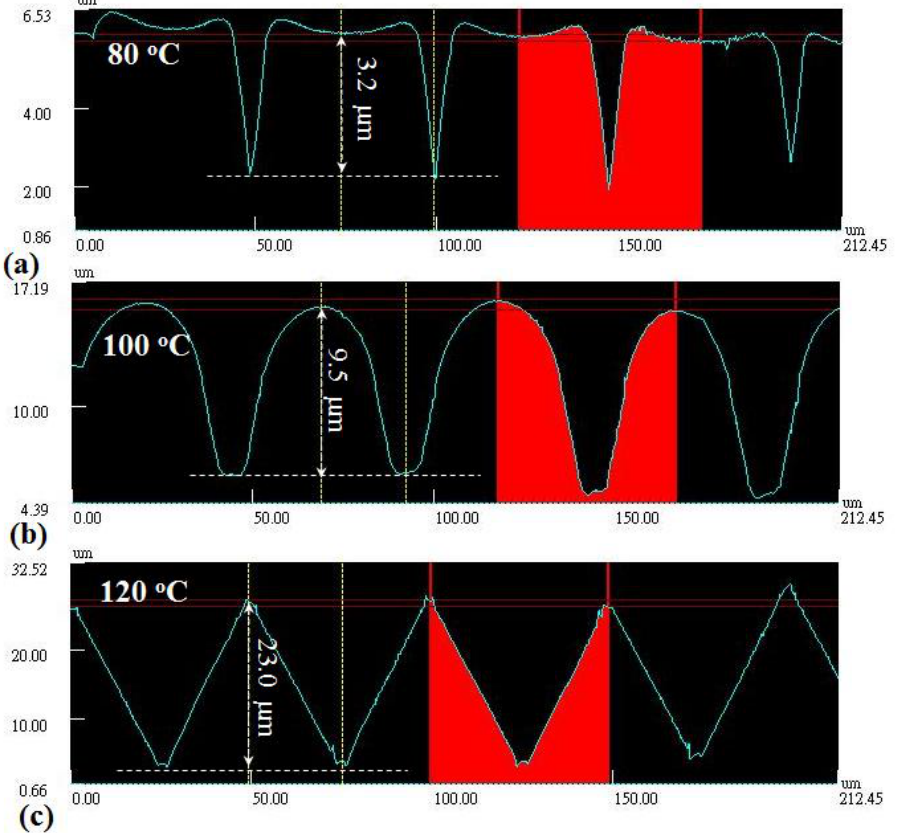
Figure 11. Cross-section views of the embossed samples under temperature settings of ( a ) 80 °C; ( b ) 100 °C and ( c ) 120 °C, scanned by the laser scanning confocal microscope. The height differences of the marked patterns were 3.2, 9.5 and 23.0 µm for the temperature settings of 80, 100 and 120 °C,